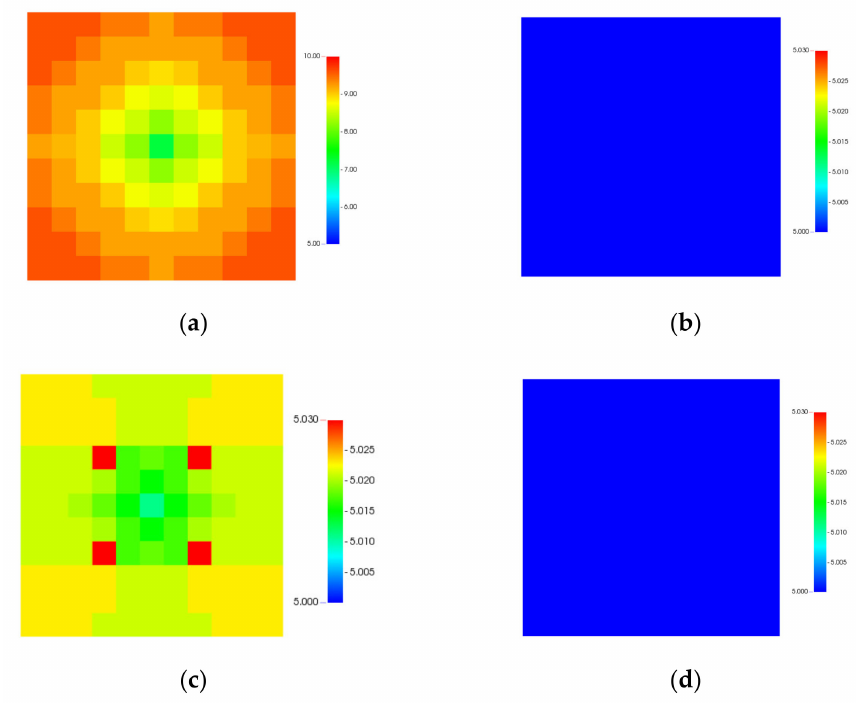
Figure 4. Reservoir pressure profiles calculated by CMG. ( a ) The 0.001th day; ( b ) the 10th day; ( c ) the 30th day; ( d ) the 200th